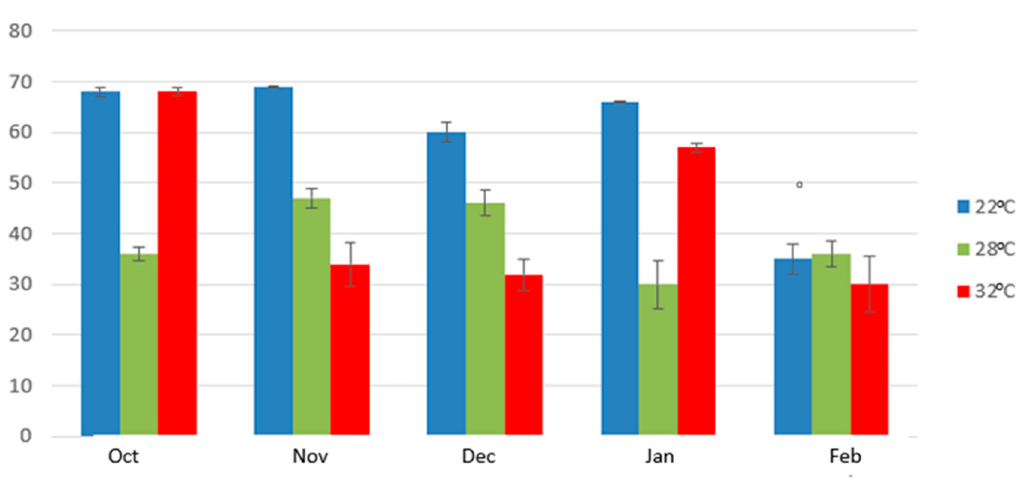
Figure 5. The % decrease of phenolic substances from 15 min to 90 min of malaxation for cv Koroneiki at three malaxation temperatures.